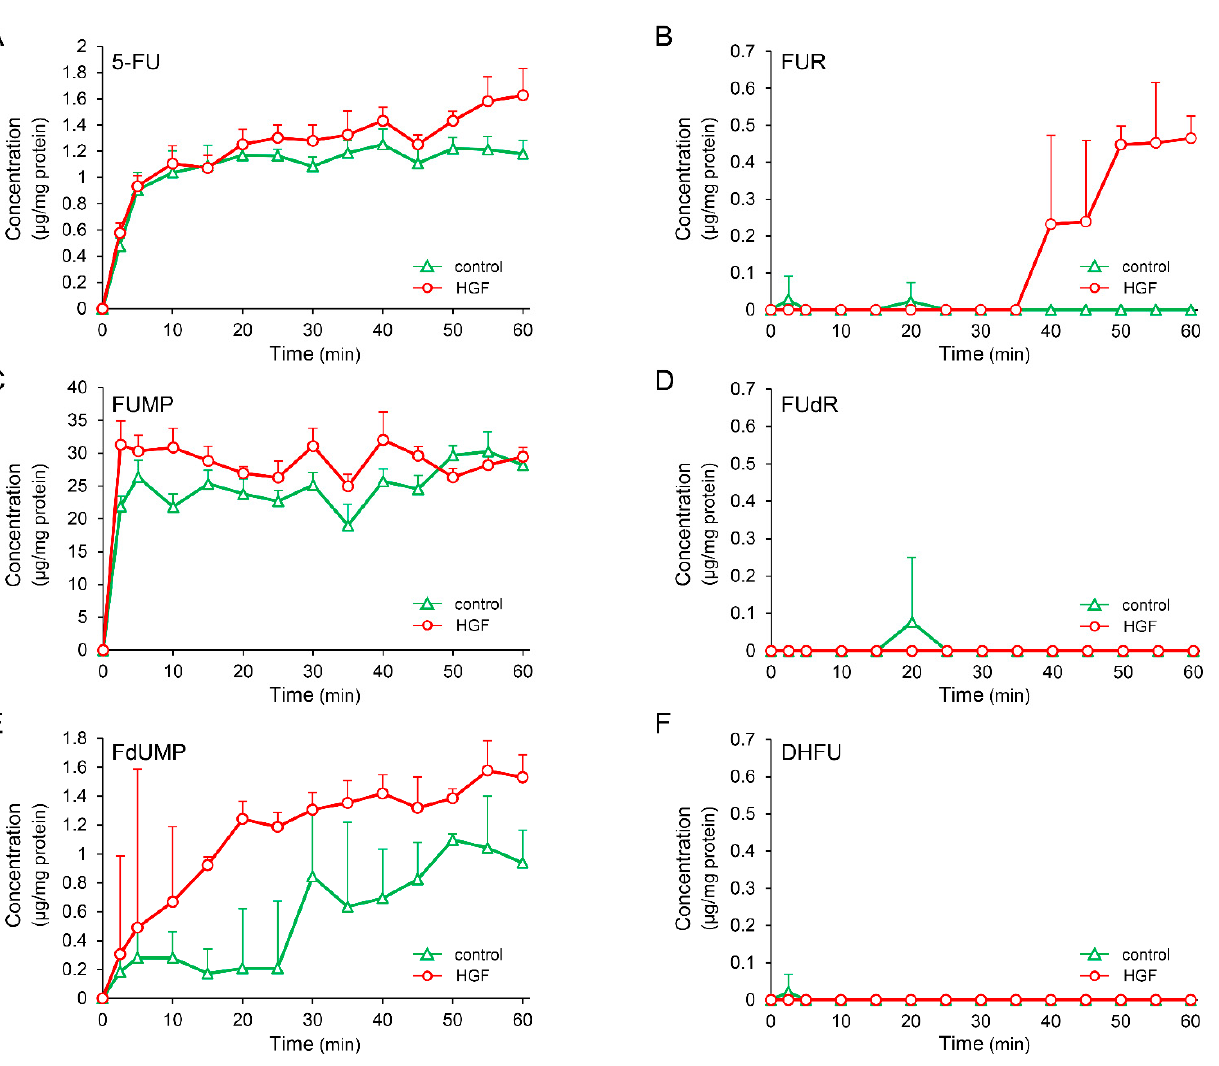
Figure 3. HGF increases concentration of FUR, an initial anabolite of 5-FU converted by UPP1. HepG2 cells, with or without HGF (50 ng/mL) treatment, were cultured for 7 h, followed by addition of 5-FU. The anabolites were collected at the indicated time points, and the concentration was determined by dividing the amount of anabolite by the protein concentration of the cell lysate. Each bar represents the mean ± SD of 5 experiments. 5-FU: ( A ), FUR: ( B ), FUMP: ( C ), FUdR: ( D ), FdUMP: ( E ), DHFU: ( F ).